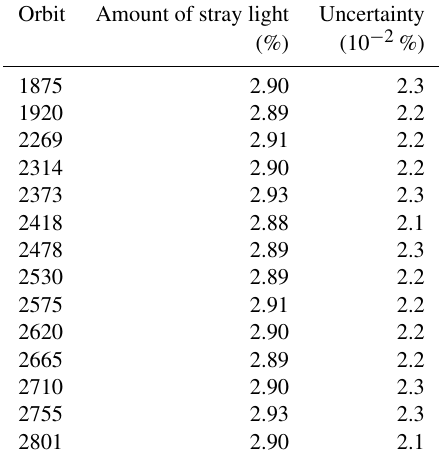
Table 4. Percentage of light detected on the SWIR detector outside of the central 15 pixels of a response to diode laser SLS-1 during the E1